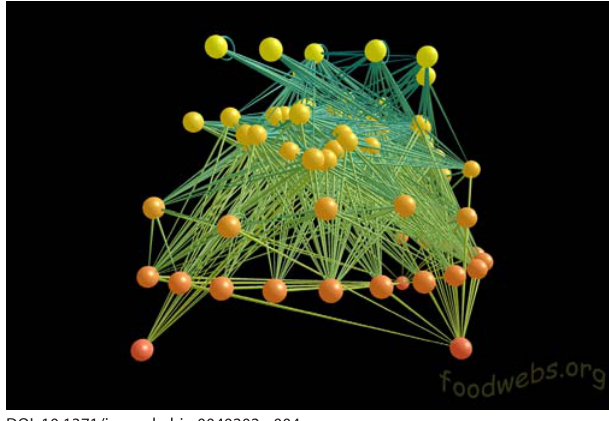
Figure 4. Food Web from a Caribbean